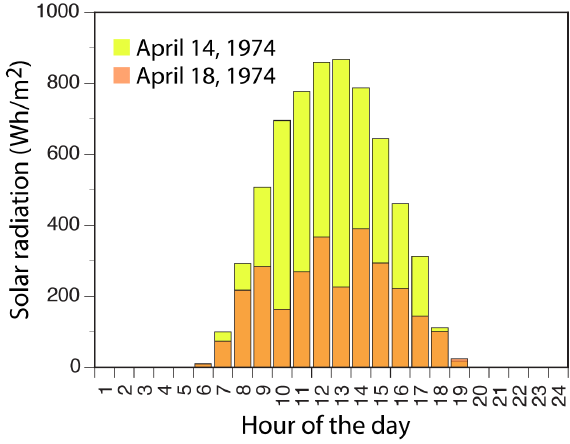
Figure 14. Solar radiation intensities for typical clear and overcast